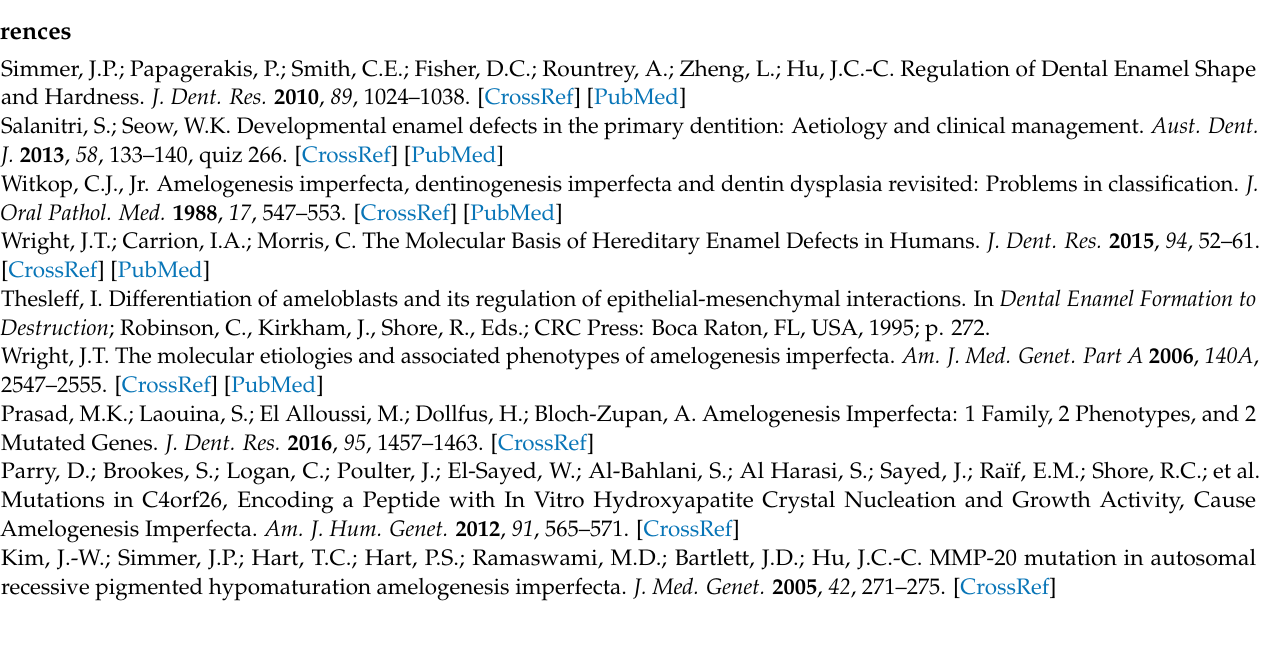
chromatograms of the participating individuals of family 2, Figure S4: Sequencing chromatograms of the participating individuals of family 3, Figure S5: Sequencing chromatograms of the participating individuals of family 4, Table S1: Statistics for exome